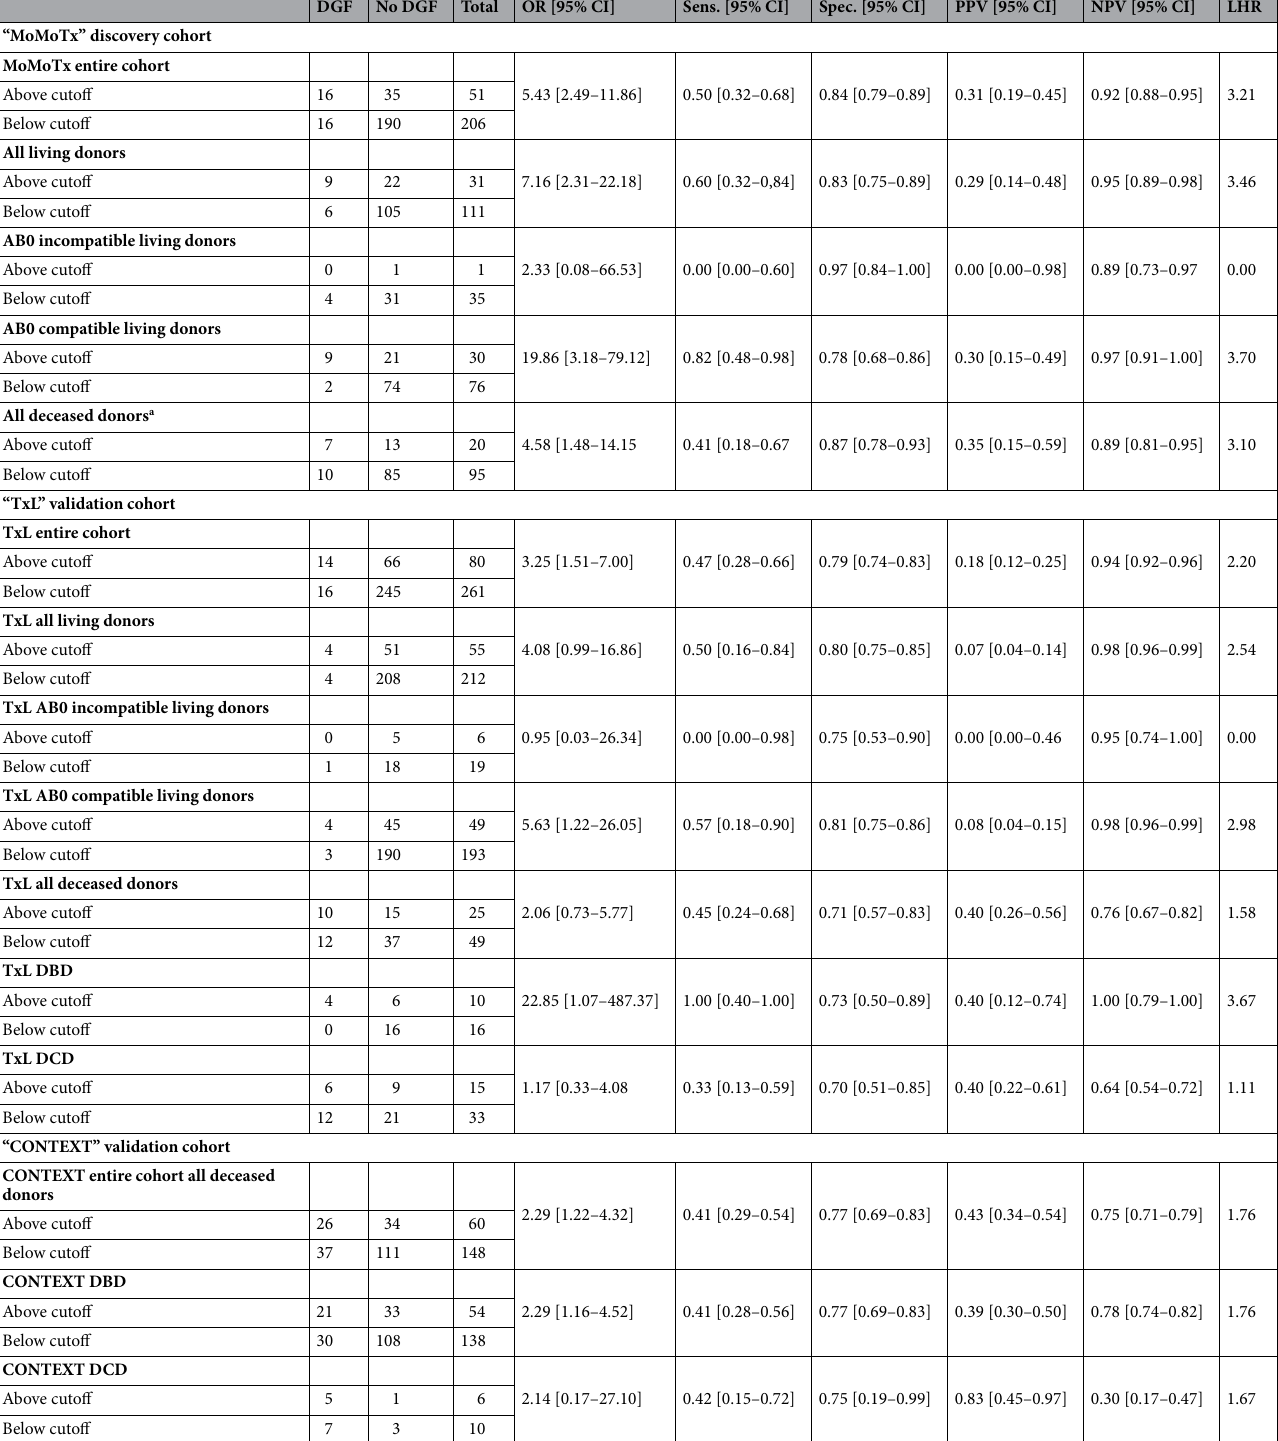
Table 3. Performance of pretransplant plasma endotrophin for delayed graft function in the discovery cohort and in the validation cohorts. “MoMoTx” Molecular Monitoring after kidney transplantation, DGR delayed graft function, OR odds ratio, Sens sensitivity, Spec specificity, PPV positive predictive values, NPV negative predictive value, LHR likelihood ratio. The cut-off level determined using Youden index was 61.65 ng/mL. a All deceased donors in the “MoMoTx” discovery cohort were donation after brain death